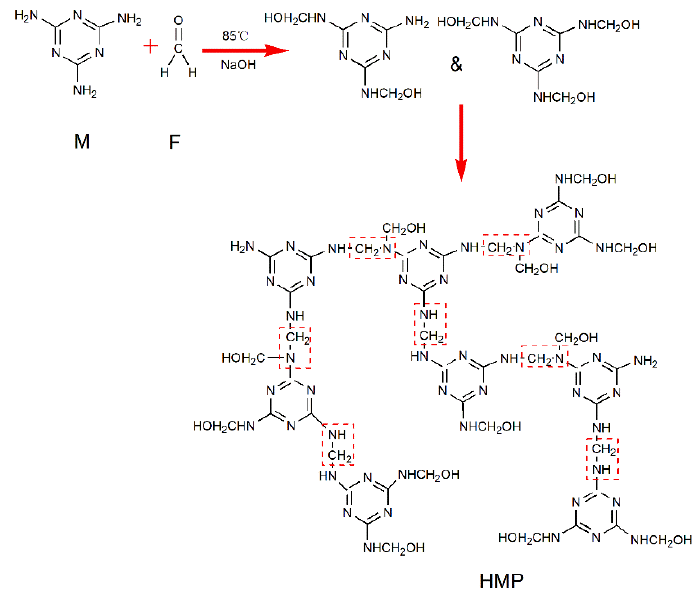
Figure 3. Chemical reaction synthesis of HMP.